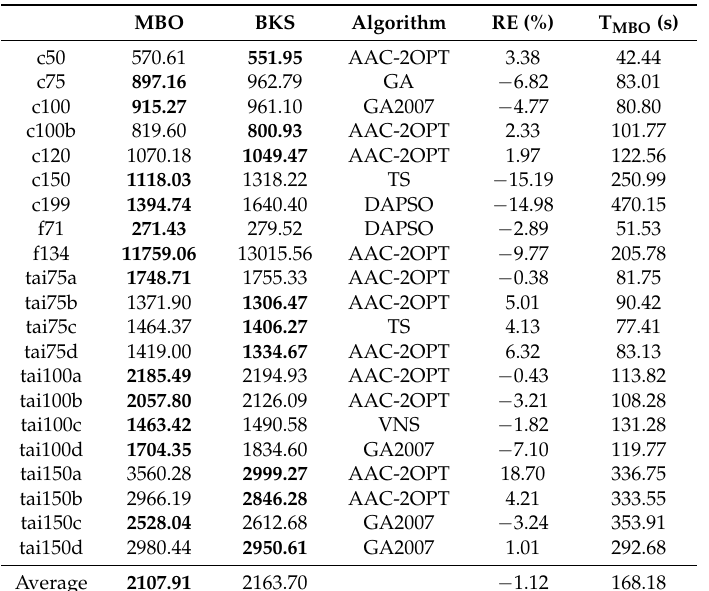
Table 1. Comparison of the best Monarch Butterfly Optimization (MBO) results with the hitherto best-known